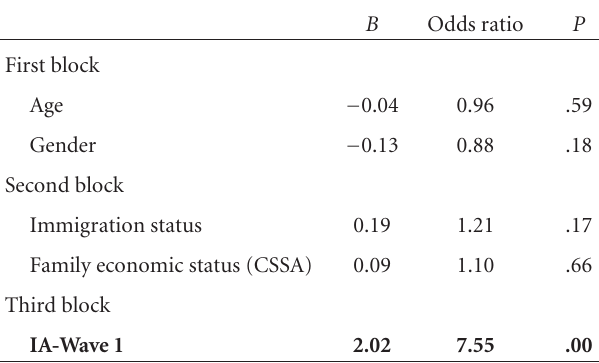
Table 4: Logistic regression analyses on students’ Internet addic-